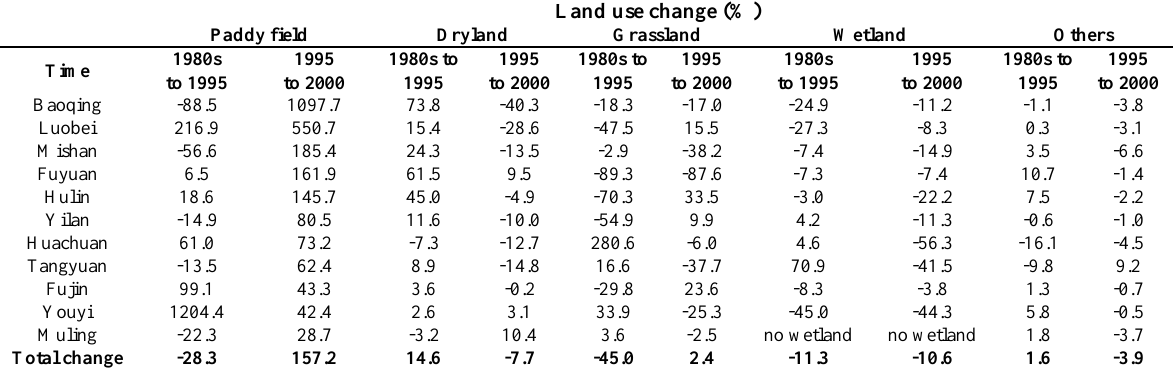
Table 2. Land use change (%) for selected classes from the 1980s to 2000 in the SJP for the representative